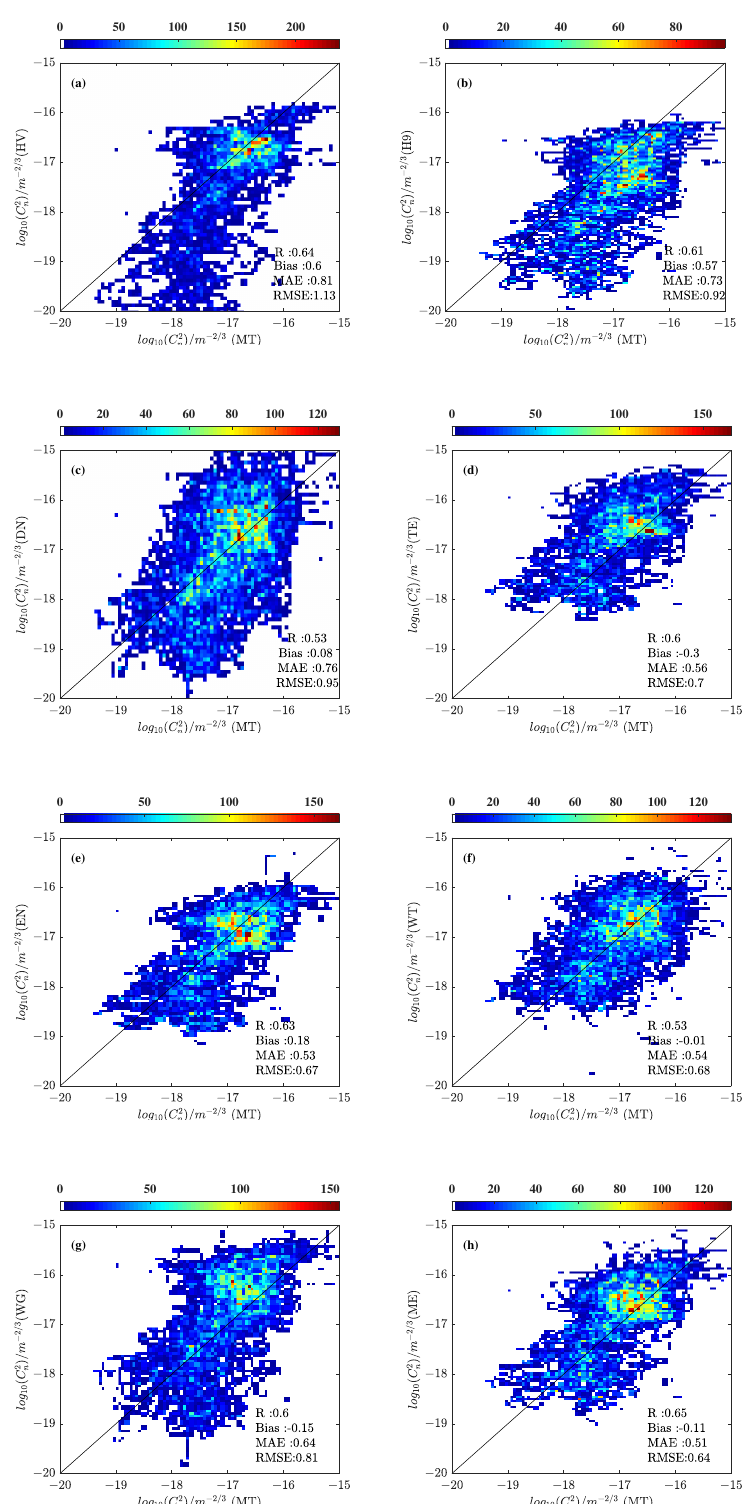
Figure 4. ECACN all launches MT vs. estimations C 2 n scatter diagrams. ( a ): MT vs. Hafnagel-Valley 5/7; ( b ) MT vs. Hmnsp99; ( c ): MT vs. Dewan; ( d ): MT vs. Thorpe; ( e ): MT vs. Ellison; ( f ): MT vs. WSPT; ( g ): MT vs. WSTG; ( h ): MT vs. MEP. The color indicates the frequency distribution of C 2 n